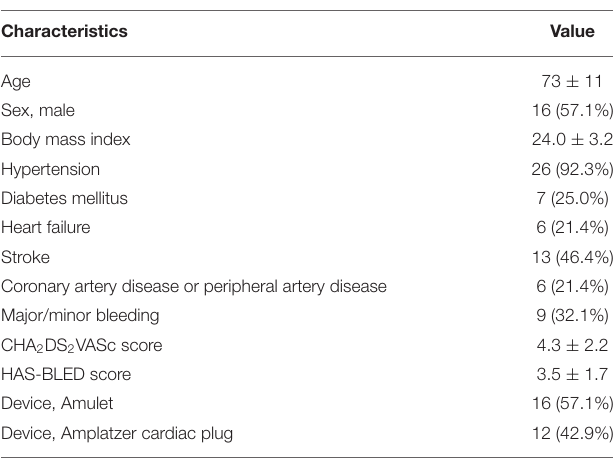
TABLE 1 | Baseline clinical characteristics.